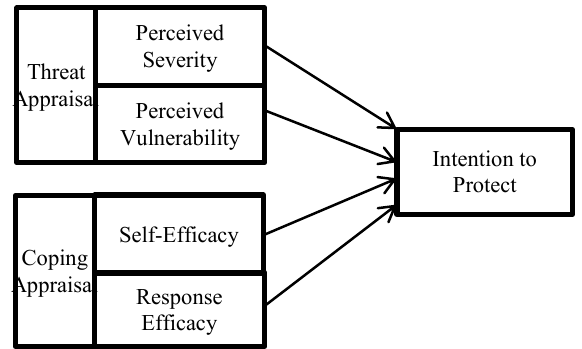
Figure 1: Protection Motivation